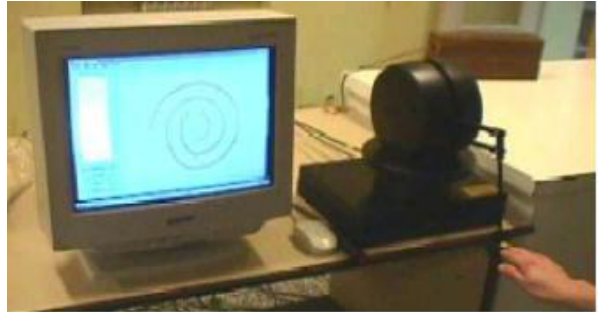
Figure 5. Example of movement test displayed on a computer